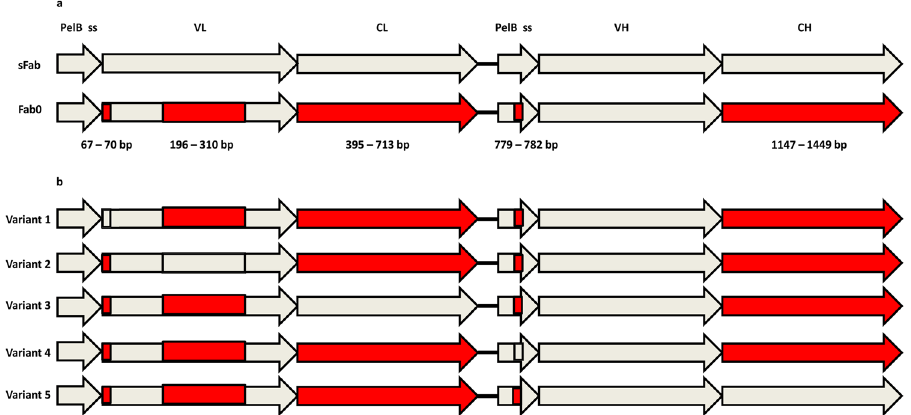
Figure 1. Illustration of the parent genes and the chimeric variants. ( a ) The parental genes sFab (codon- optimized) and Fab0 (harmonized). The five altered segments (the numbers on top) are indicated by red tiles and base-pair numbers (counted from the start codon in the light chain signal sequence), and include: 1. The start of variable light region (de-optimization of codon pair), 2. Frame2-CDRL2-frame3 of variable light region (harmonization), 3. Constant light region (harmonization), 4. PelB signal sequence (de-optimization of leucine codon pair) and 5. Constant heavy region (harmonization). ( b ) Chimeric variants obtained by replacing one of the codon harmonized segments in Fab0 with the corresponding codon-optimized sequence (indicated by white tiles with black outline).